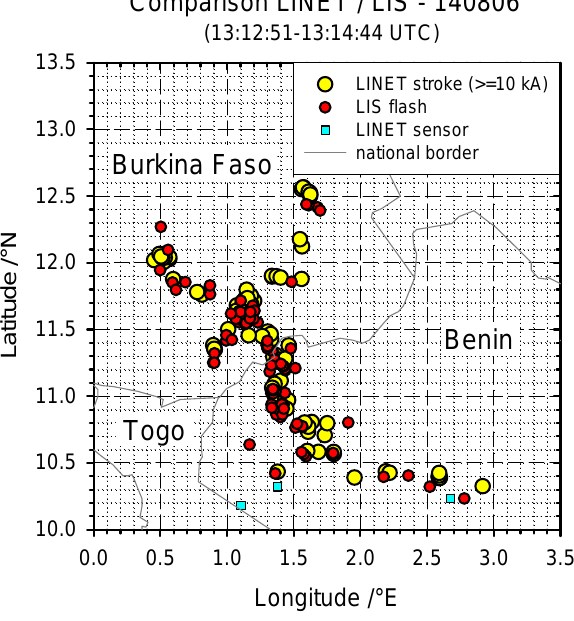
Fig. 14. Horizontal distributions of LIS flashes (in red) and LINET strokes with peak currents ≥ 10 kA (in yellow) during the LIS overpass over the LINET area on 14 August 2006. Close-by detecting LINET sensors are superimposed (in cyan).